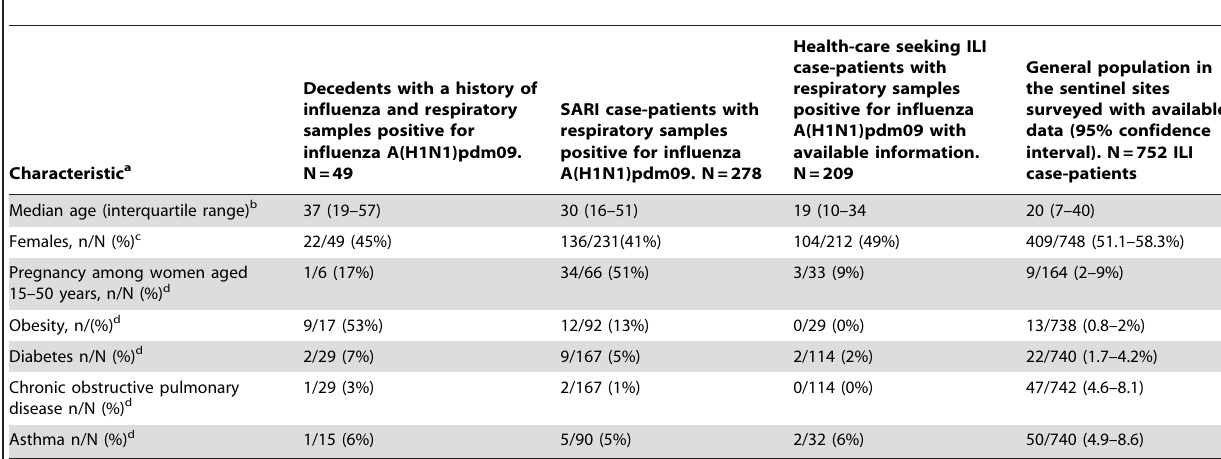
Table 4. Description of case-patients with available risk factor data identified during active case-finding in 2009 and during three consecutive health utilization surveys in 2010, three cities in